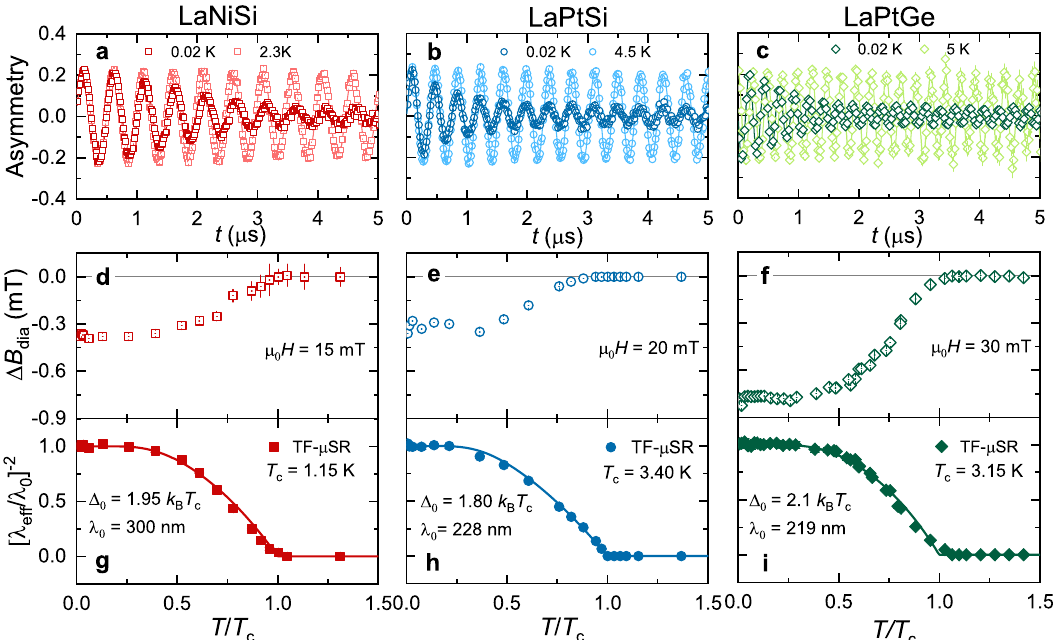
Fig. 4 Exploring the superconducting pairing via TF- μ SR. a – c TF- μ SR spectra, collected in the superconducting and normal states (i.e., above and below T c ) of LaNiSi ( a ), LaPtSi ( b ), and LaPtGe ( c ). The optimal fi eld values for the TF- μ SR measurements were identi fi ed from the lower critical fi eld H c1 and the fi eld-dependent superconducting relaxation rate (see Fig. 2, Supplementary Fig. 8 and Note 6) and correspond to 15, 20, and 30 mT for LaNiSi, LaPtSi, and LaPtGe, respectively. d – f Diamagnetic shift Δ B dia versus the reduced temperature T / T c for LaNiSi ( d ), LaPtSi ( e ), and LaPtGe ( f ). Here, Δ B dia = B s − B appl , with B s the local magnetic fi eld sensed by implanted muons in the sample and B appl the applied magnetic fi eld. Due to the formation of the FLL, a diamagnetic fi eld shift appears below T c . g – i Super fl uid density [ ρ sc ð T Þ / λ (cid:2) 2 a function of reduced temperature T / T c for LaNiSi ( g ), LaPtSi ( h ), and LaPtGe ( i ). Solid lines represent fi ts to a fully-gapped s -wave model. The error bars of λ − 2 ( T ) are the SDs obtained from fi ts of the TF- μ SR spectra to Eq. (3) by the musr fi t software package 52 .